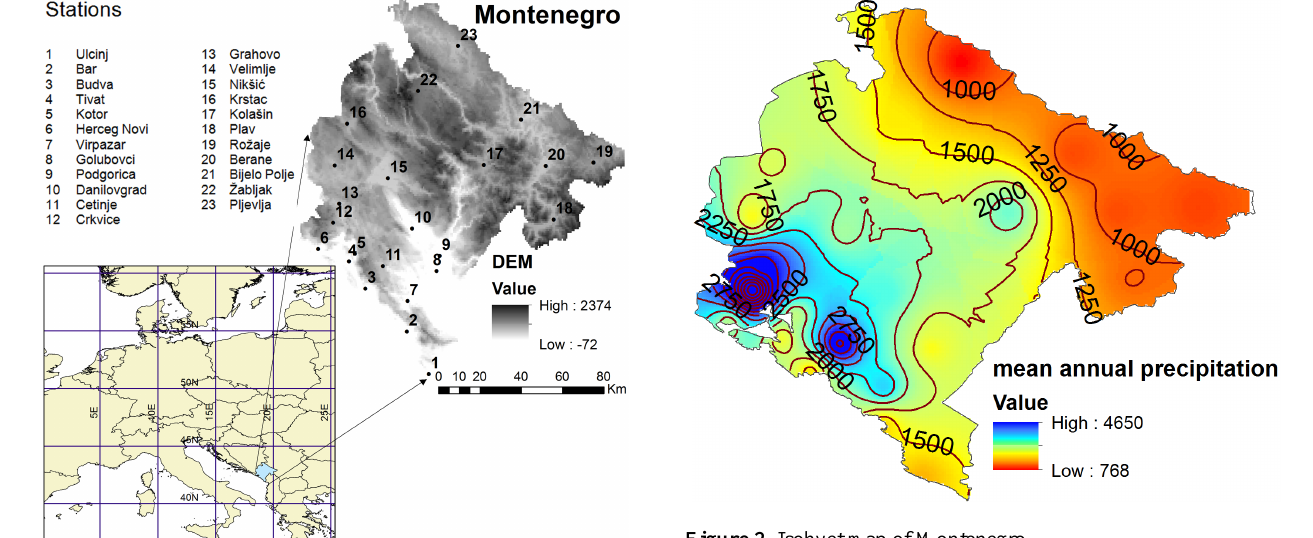
Figure 2. Isohyet map of